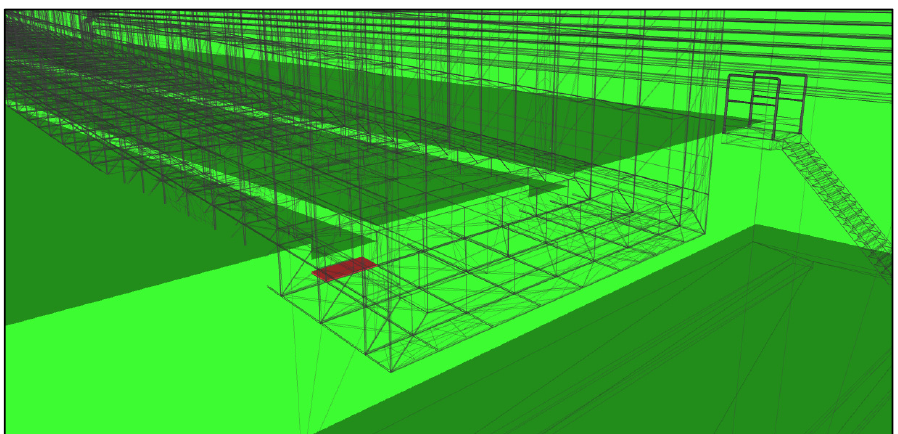
Figure 24. Results Clash detective between decay and flooring experimental area.